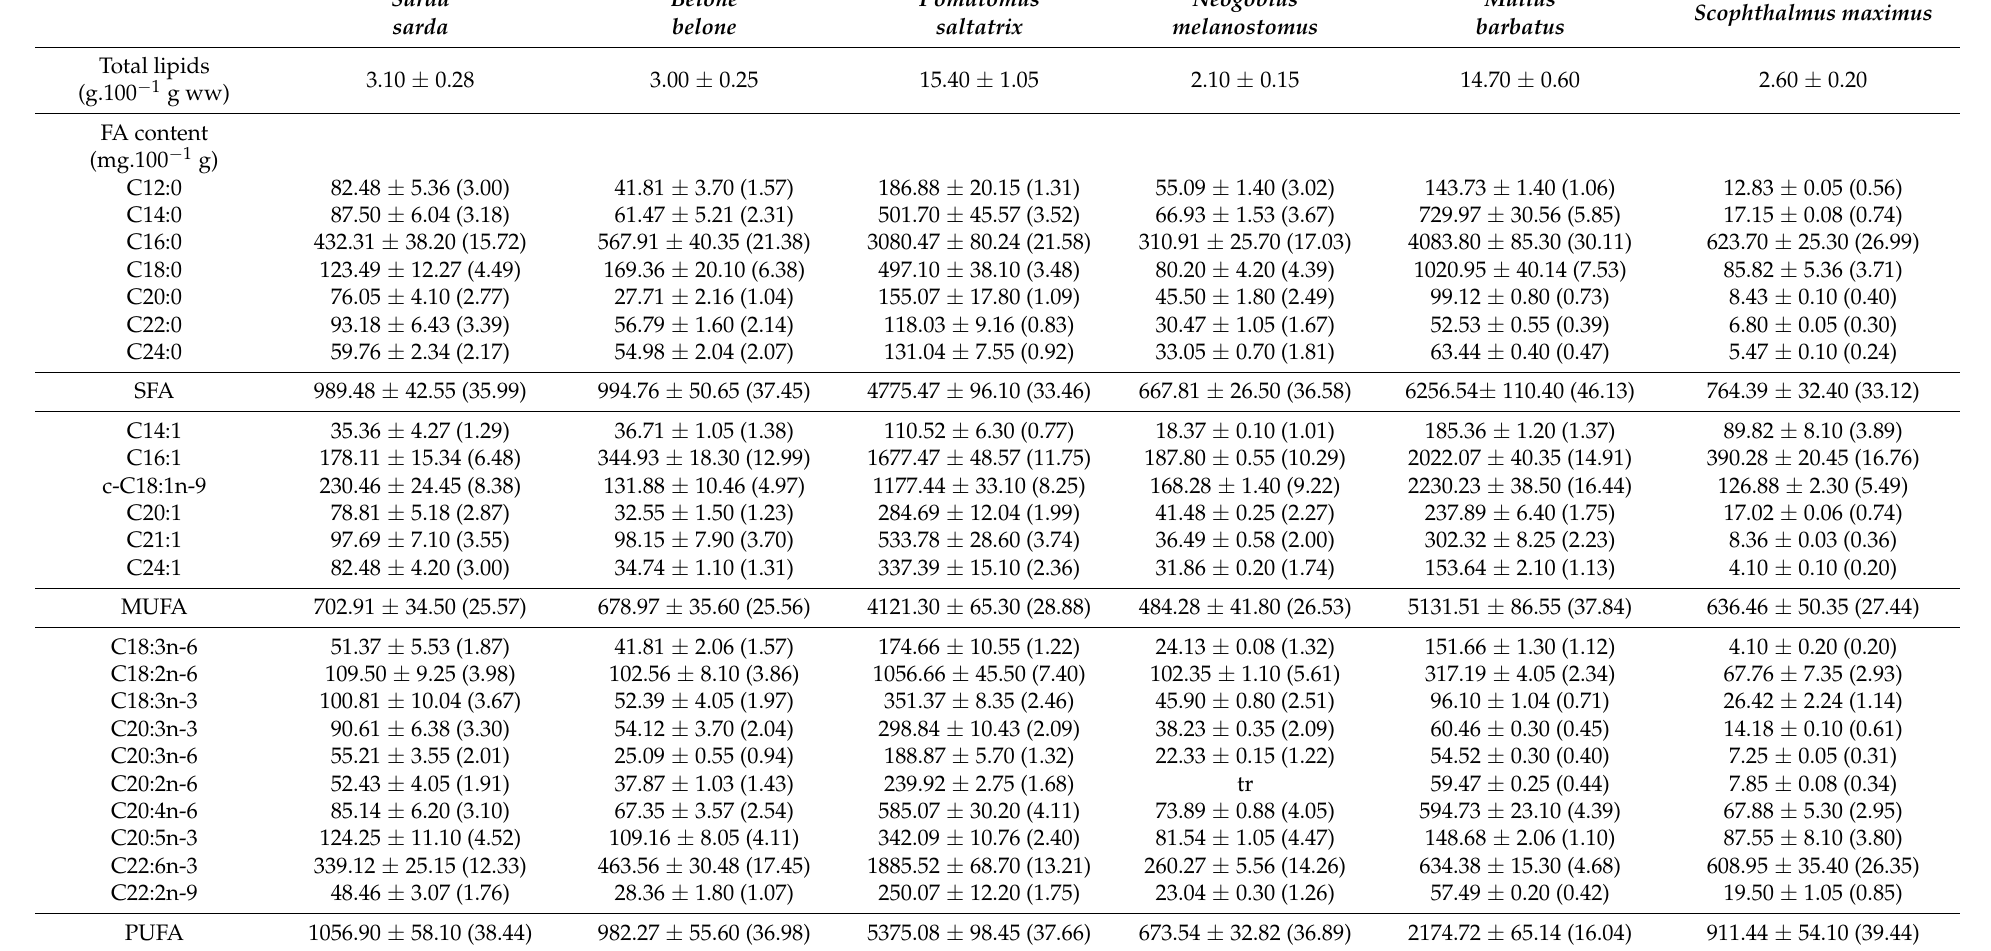
Results represent mean values ± standard deviation (n = 3); SFA: saturated fatty acids; MUFA: monounsaturated fatty acids; PUFA: polyunsaturated fatty acids; n-3: omega-3; nd: not detected; tr: trace amounts,